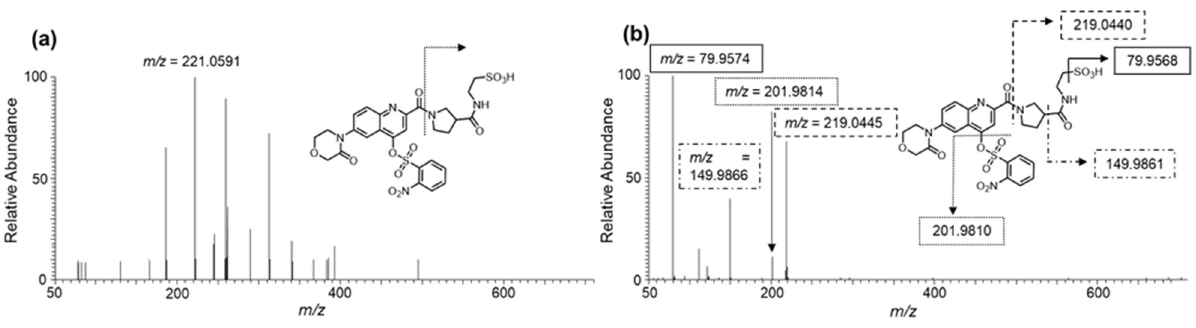
Figure 5. MS/MS spectra of derivatized Tau with Ns-MOK-( S )-Pro-OSu using ESI (+) CE 30% ( a ) and ESI ( − ) CE 30% modes ( b ).